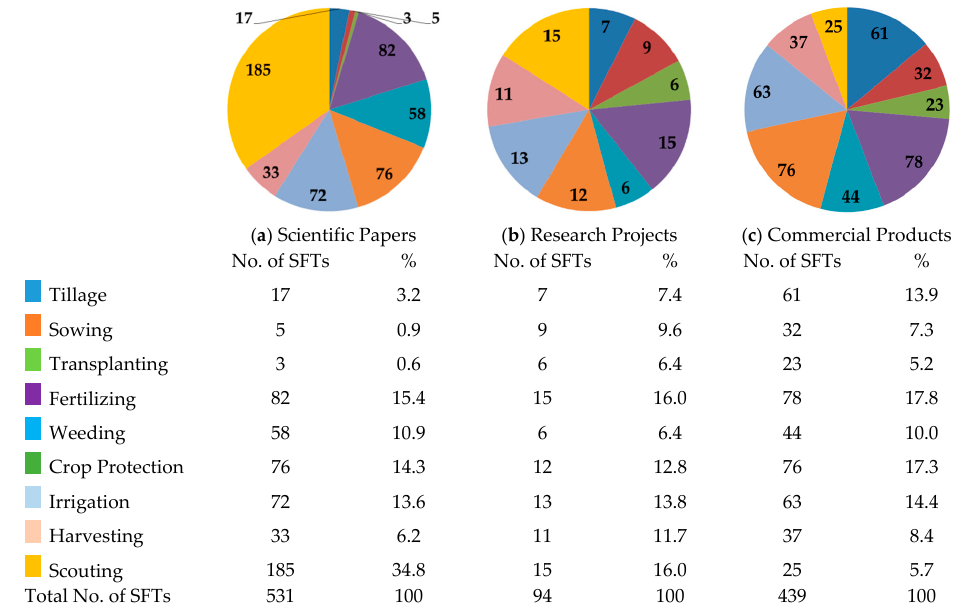
Figure 4. Allocation of the identified smart farming technologies (SFTs) to each category that addresses a certain field operation (tillage, sowing, transplanting, fertilizing, weeding, crop protection, irrigation, harvesting, and crop / soil scouting) in ( a ) scientific papers, ( b ) research projects, and ( c ) commercial